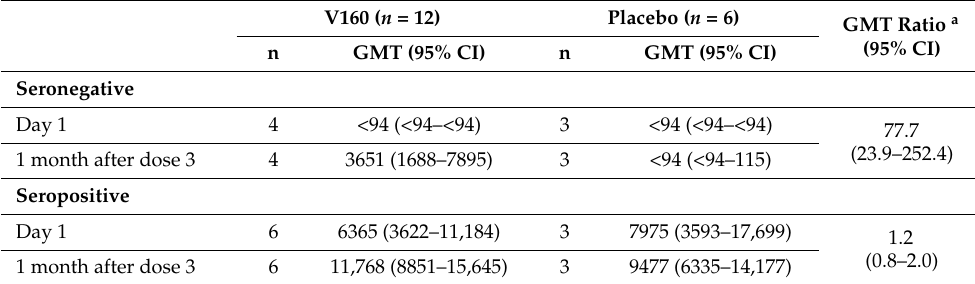
Table 1. CMV-specific neutralizing antibody GMT (PPI